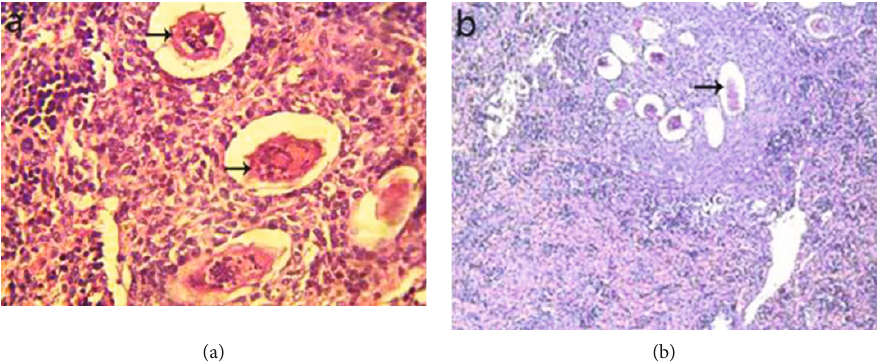
Figure 13: Histological section of infected untreated control staining with H&E: (a) spleen revealed aggregate of deposited bilharzia ova, surrounded by lympho-epithelioid tissue reaction ( × 200); (b) liver showing multiple egg granulomas and a worm impacted inside a portal vein ( ×